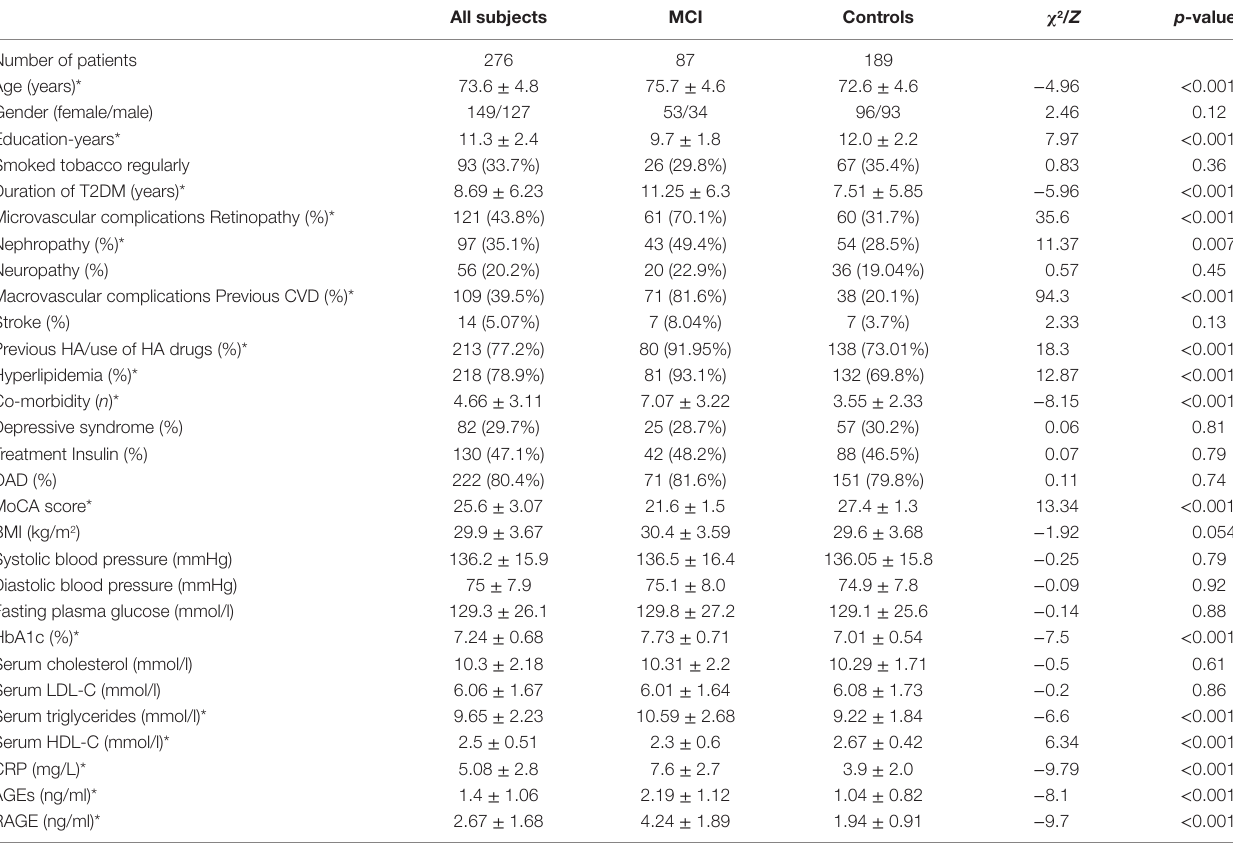
TaBle 2 | Demographic and clinical characteristics of type 2 diabetic elderly patients. all subjects